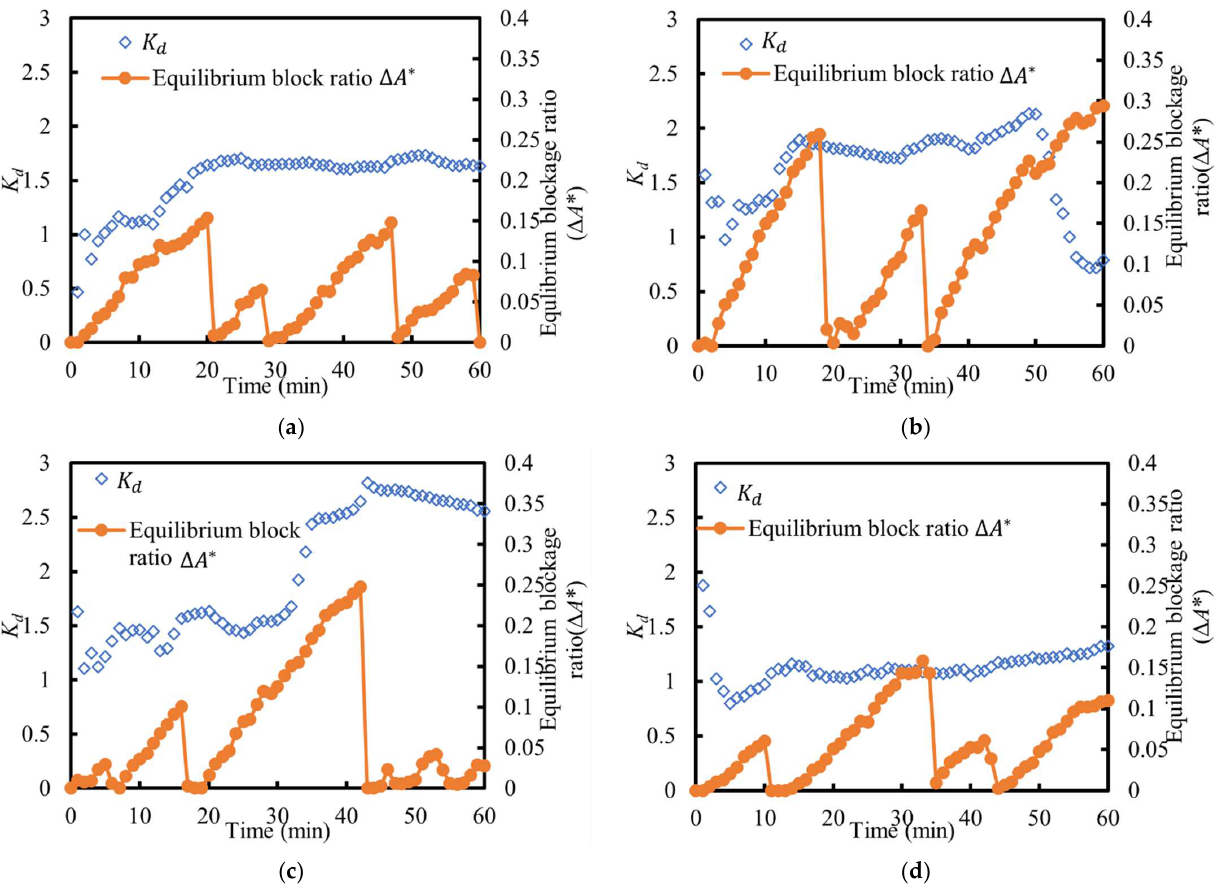
Figure 12. Time-history of the evolution of the relative scour depth K d and equilibrium blockage ratio ∆ A ∗ ( a ) test 4; ( b ) test 5; ( c ) test 6; ( d ) test 7.